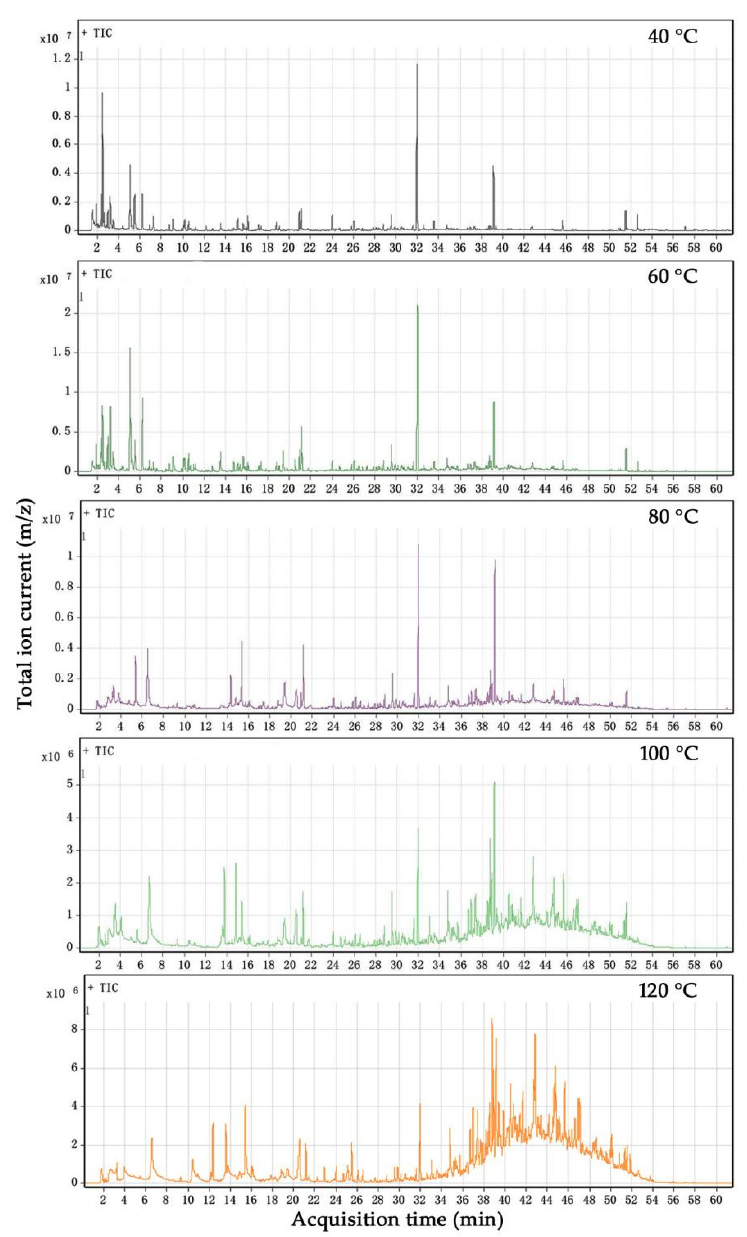
Figure 5. Total ion chromatogram (TIC) of baked beans under different temperatures.